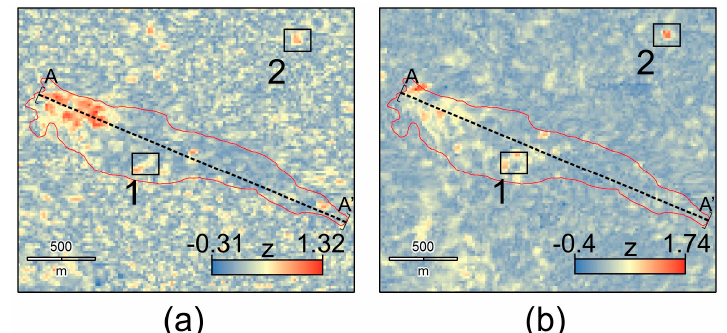
Figure 9. DPM from ( a ) Sentinel-1; and ( b ) from ALOS-2 for Amatrice. The thick dashed lines are the